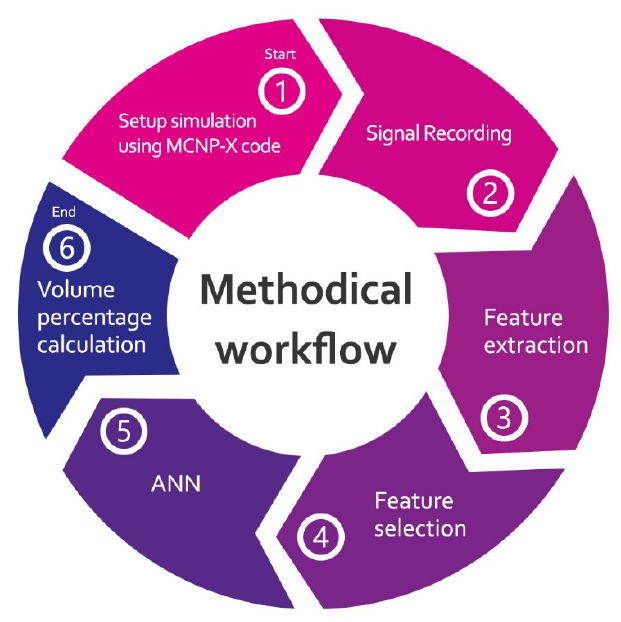
Figure 1. Methodical workflow of the proposed manner.